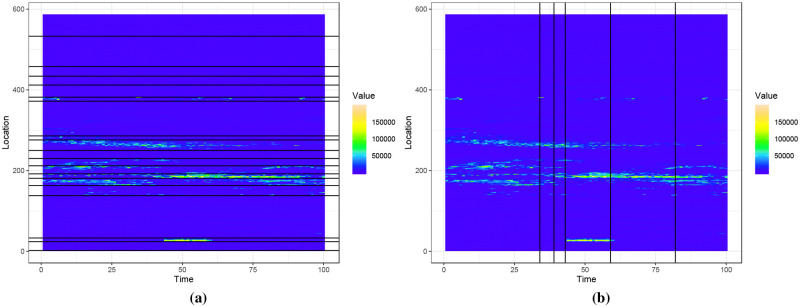
Location change points in Fig 10a and time change points in Fig 10b.